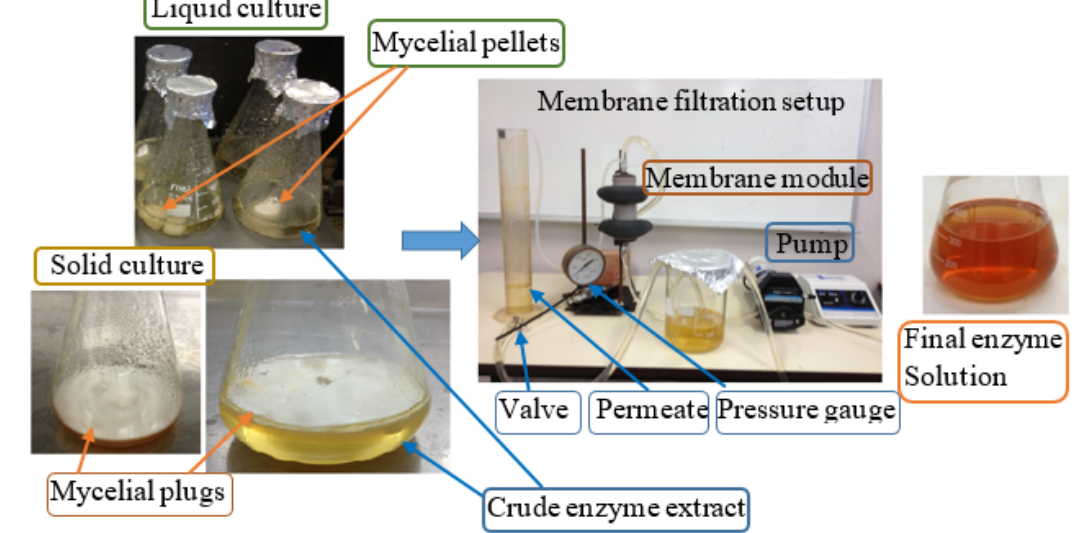
Figure 1. Mycelial pellets and mycelial plugs formation in the liquid and solid culture and the membrane filtration set up to concentrate crude enzyme extract solution.